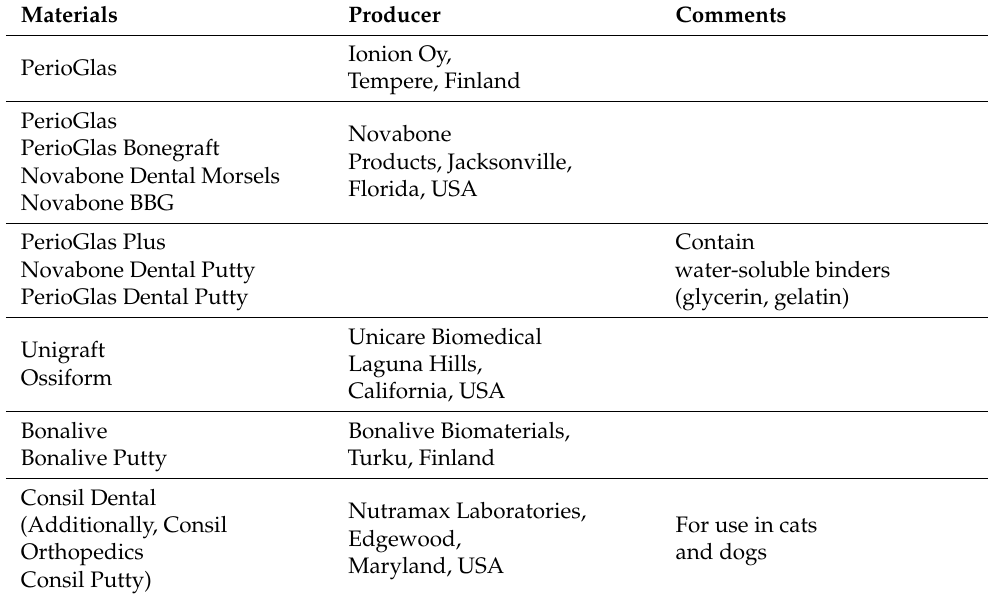
Table 5. Bioactive glass products for periodontal